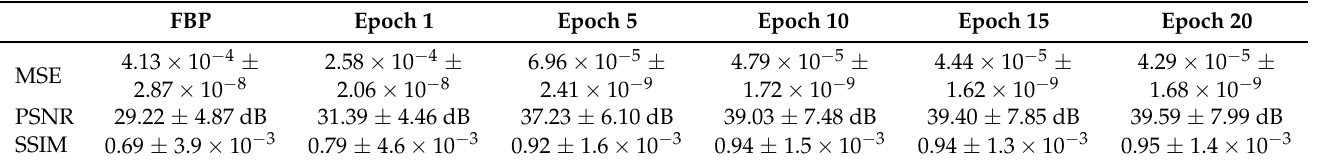
Table 3. Reconstruction metrics for test dataset.